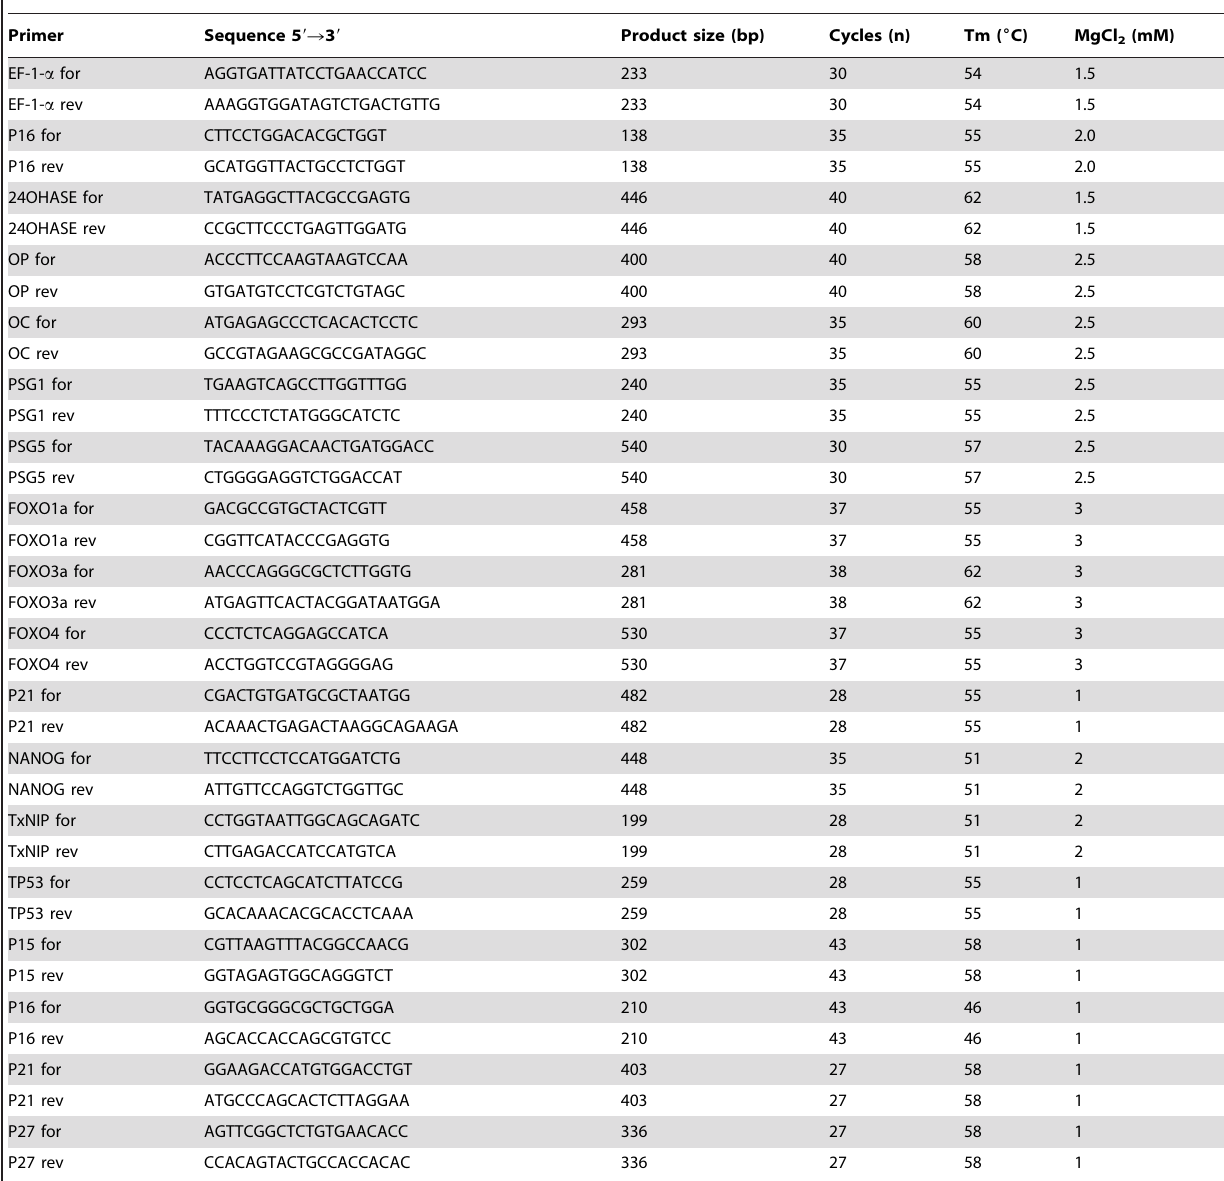
Table 1. Primers used for RT-PCR